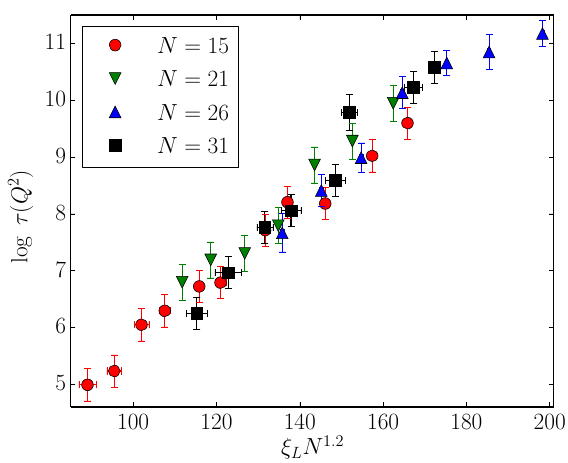
Figure 2 . Behavior of the autocorrelation time in number of sweeps τ ( Q 2 ) as a function of the empirical scaling variable ξ L N 1 . 2 .